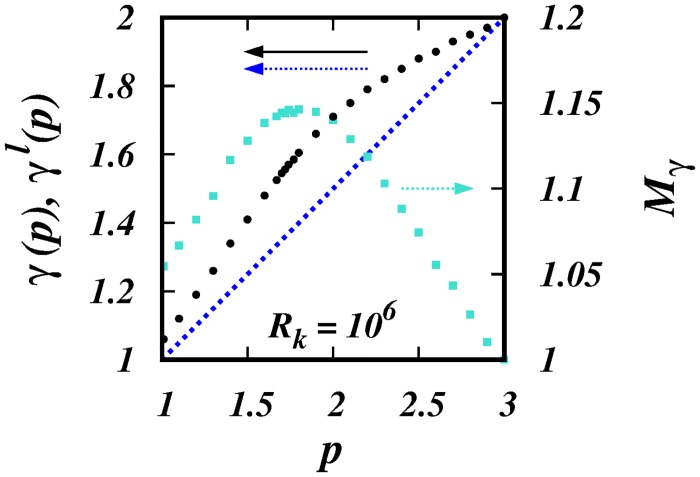
γ(p), γl(p), and Mγ(p) against p.The black filled circles are the γ(p)’s from the simulations. The dotted blue line is the locality scaling γl(p) = (1 + p)/2. The cyan squares are the ratios, Mγ = γ(p)/γl(p) (right hand scale). See Table 1.